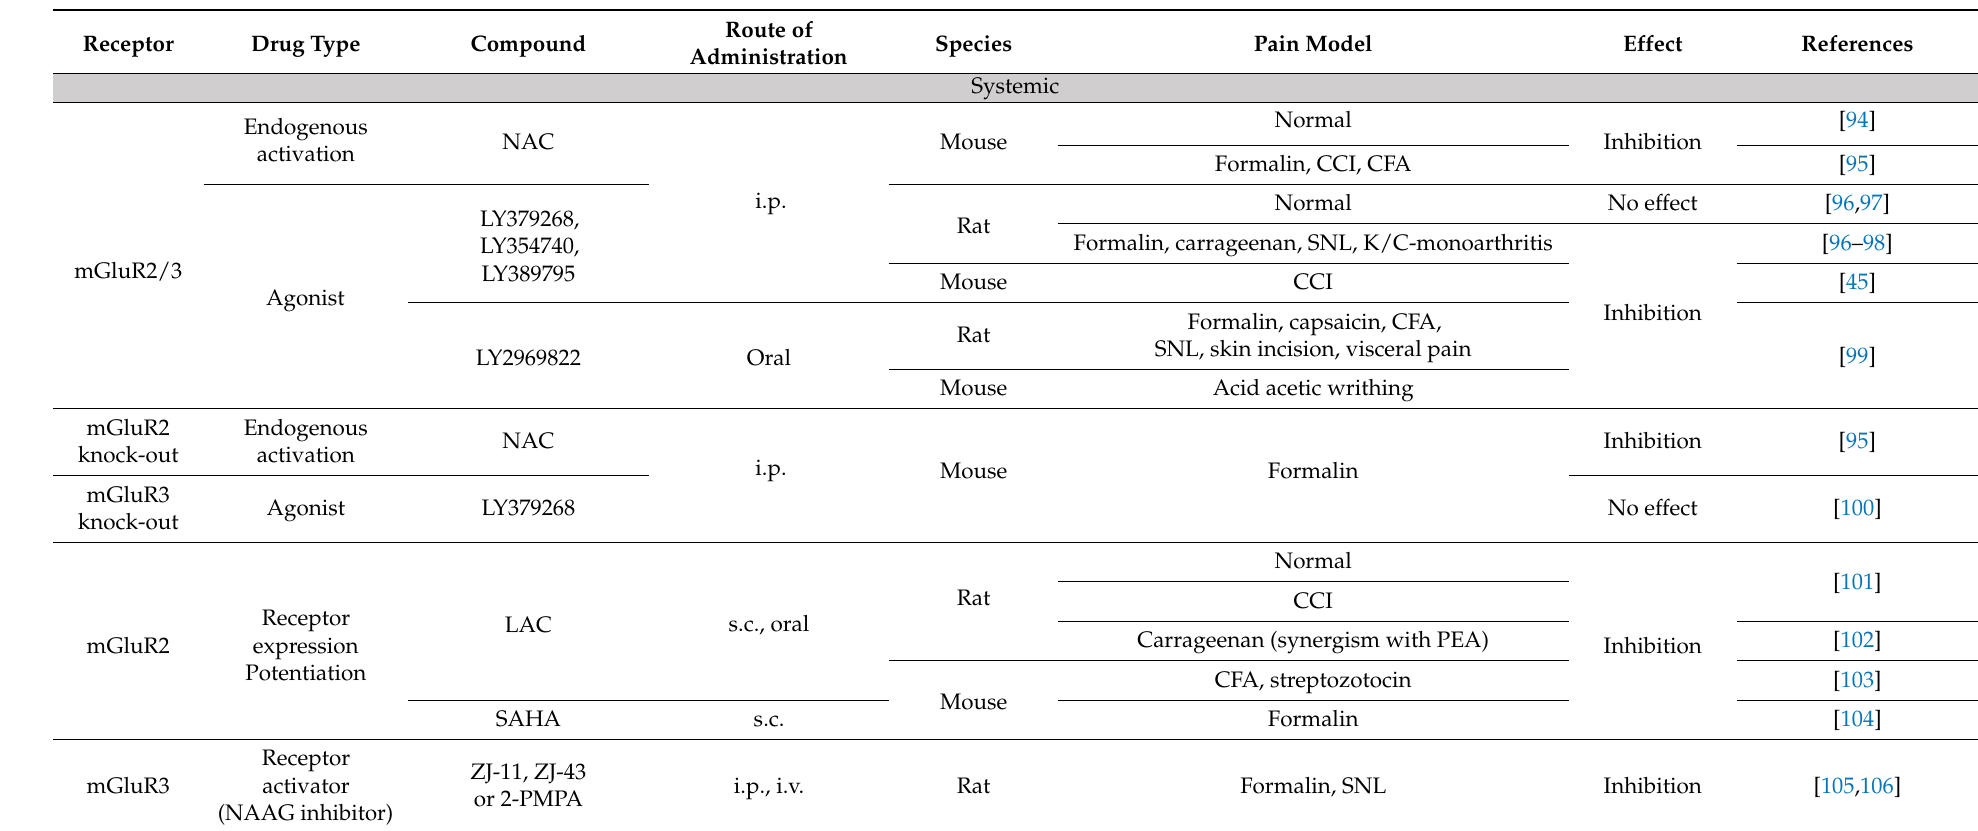
Table 2. Behavioral effects of group II mGluR drugs in preclinical pain